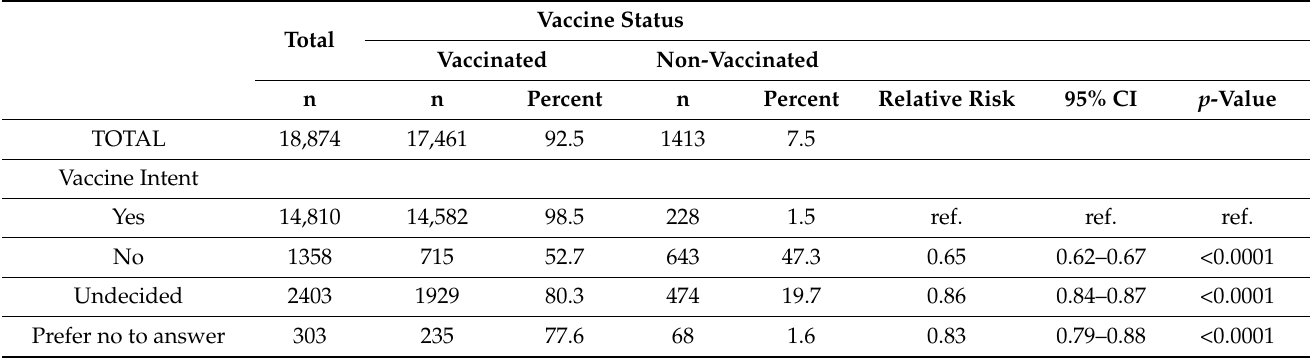
Figure 1. Reasons given by participants who did not respond “yes” on the survey. Table 1. Vaccine intent and vaccination status with Relative Risk of being vaccinated. n—number, CI—confidence interval, ref—reference.